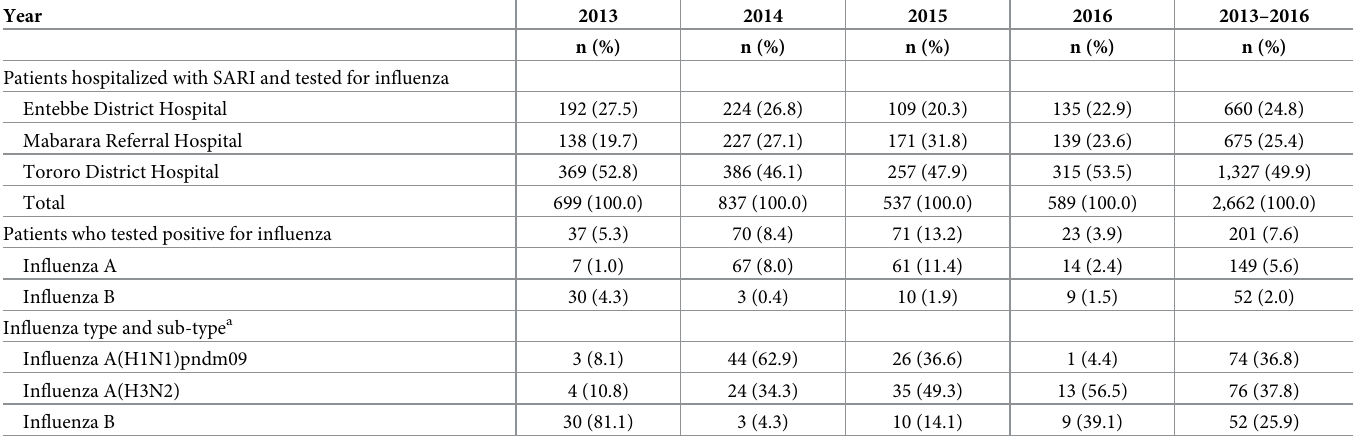
Table 2. Annual distribution of patients who were hospitalized with severe acute respiratory illness (SARI) and tested for influenza at three surveillance hospitals in Uganda,